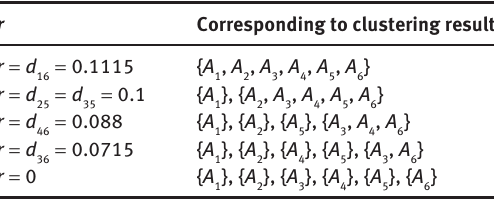
Table 3. IFMST Clustering Results of the Six Operational